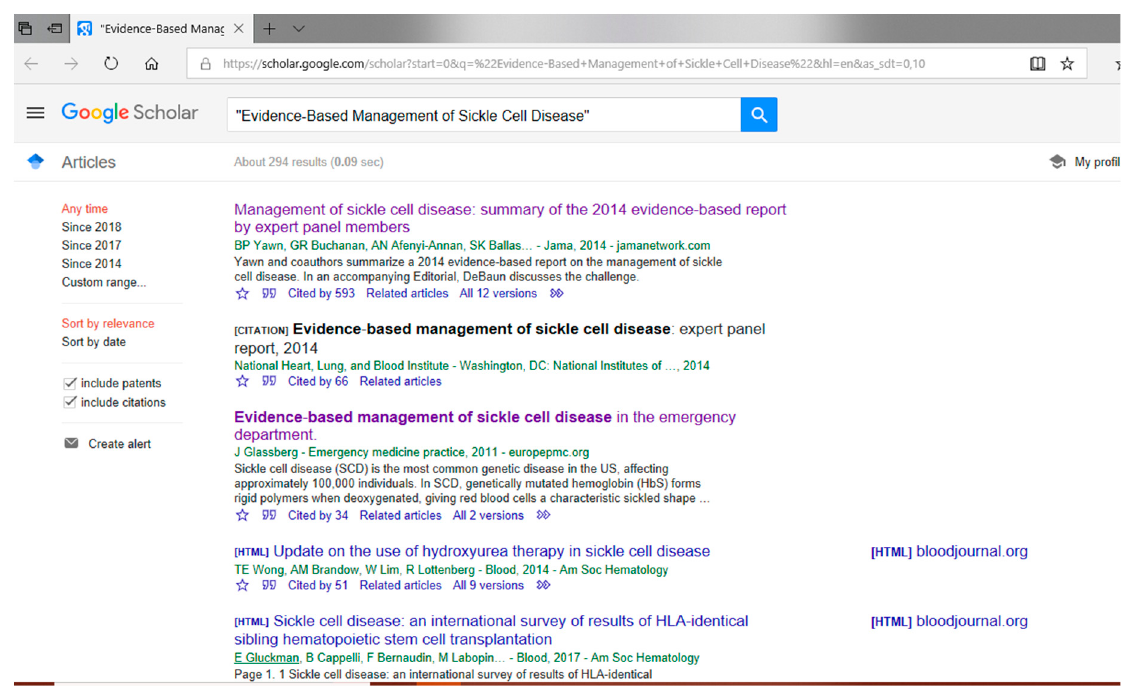
Figure 4. Search in Google Scholar for citations of the data source for interactive analytics of public health aspects of sickle cell disease.